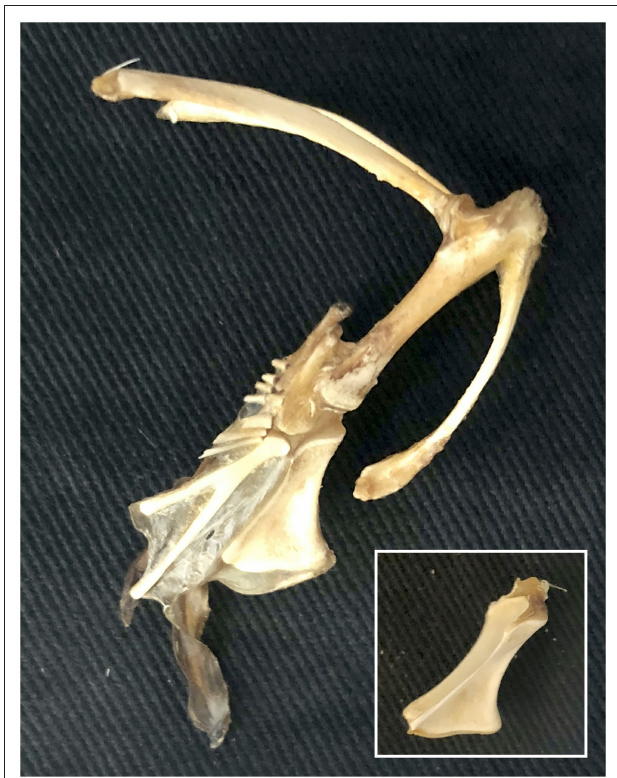
FIGURE 10 | Cartilaginous keel. The cartilaginous keel of immature birds quickly shrinks and deforms following dissection, is completely degraded by skeletal preparation (warm water bath with protein-digesting enzymes, or dermestid beetles) (inset), and thus would easily be lost in the fossil